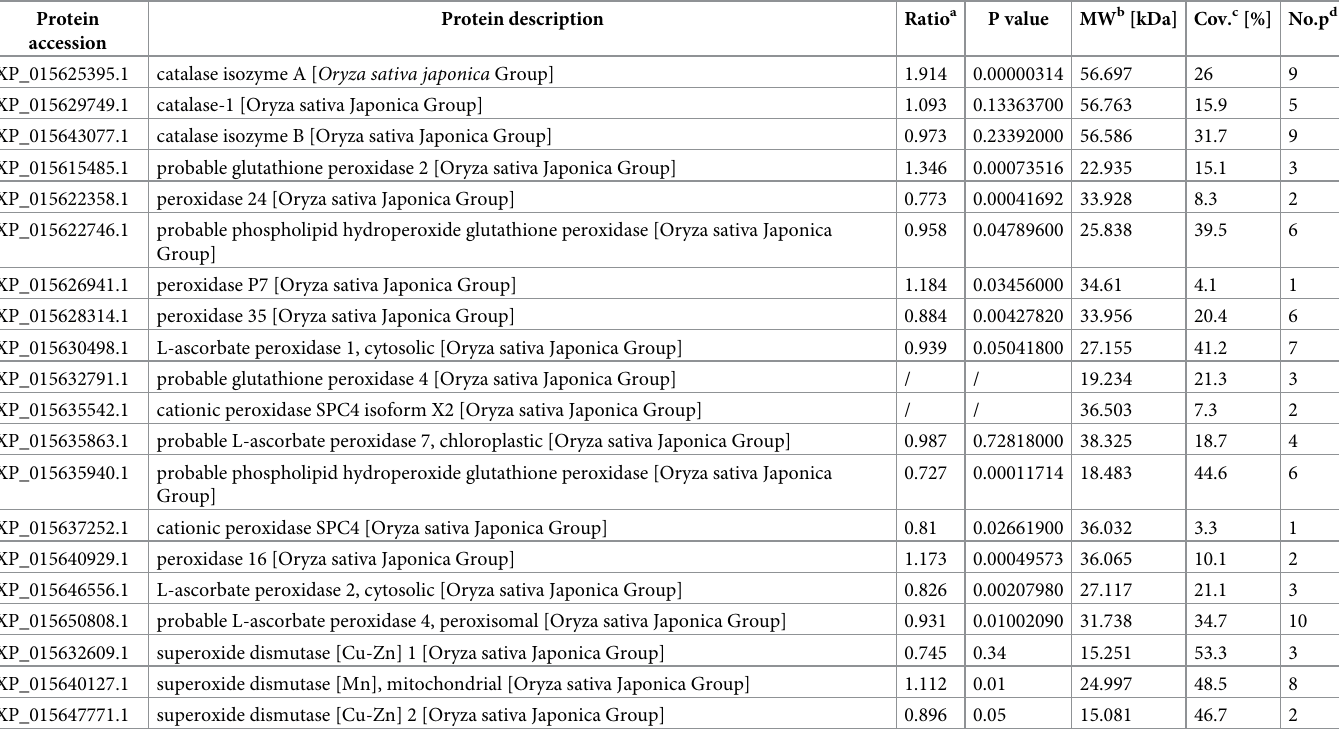
a Ratio between intensities of differentially expressed antioxidant enzyme protein in rice seed 9311-4x versus 9311-2x. b Molecular mass of the proteins. c Percentage of the protein sequence covered by matched peptides. d Number of matched unique peptides identified for each